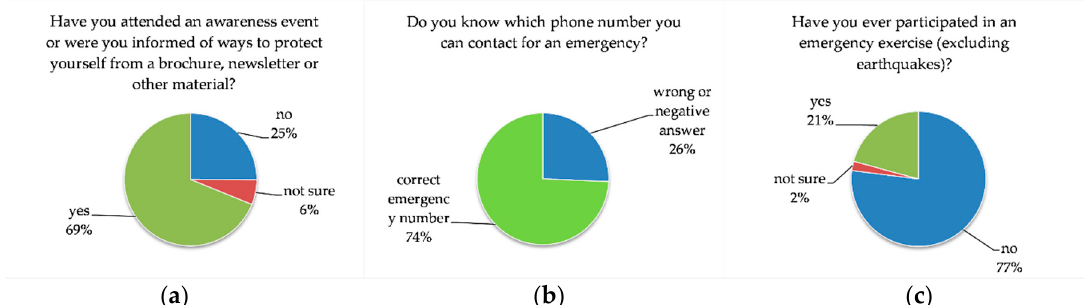
Figure 3. Survey participants’ answers about their access to: ( a ) Information, ( b ) emergency numbers, ( c ) emergency exercise for other than earthquake hazards.